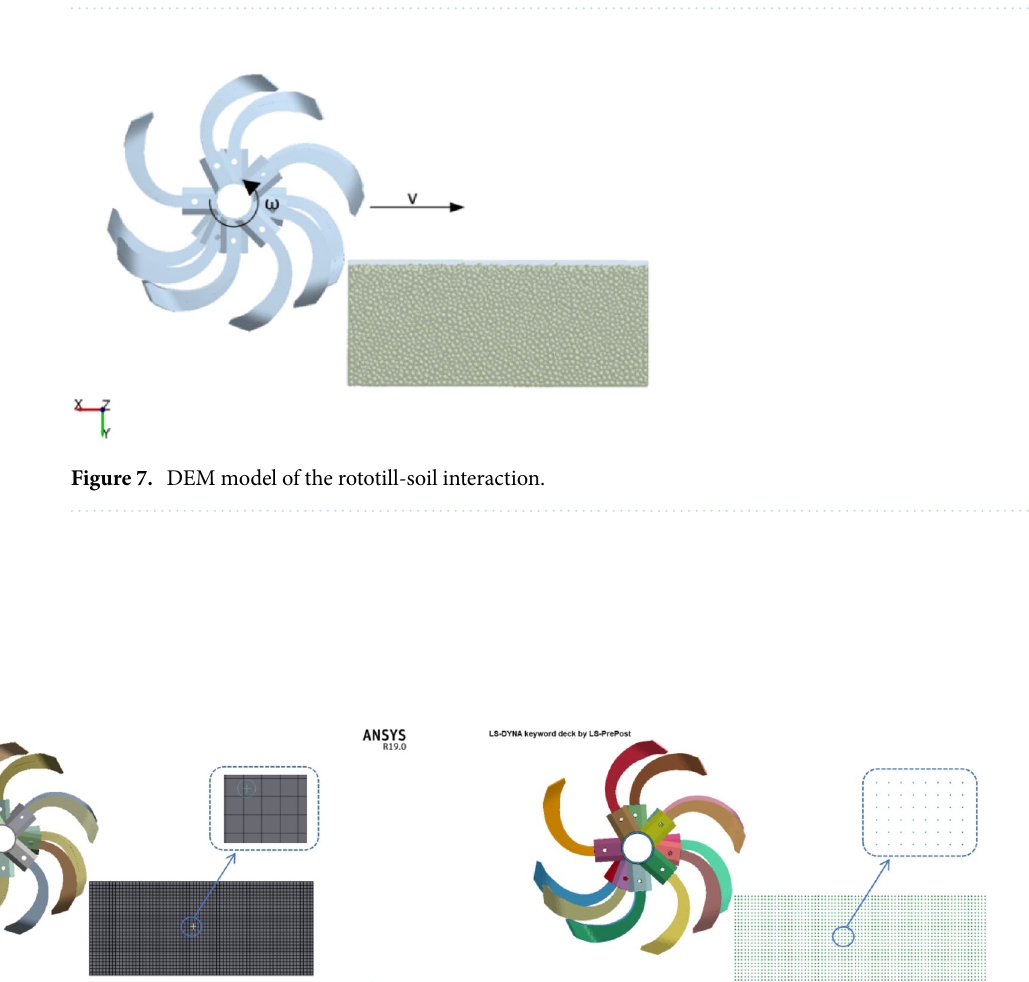
Table 4. Soil slip simulation experiment results.